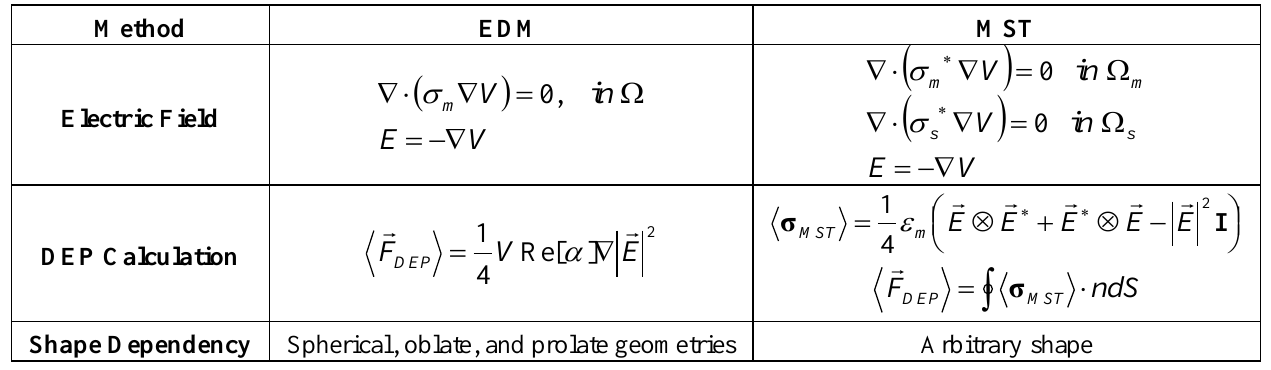
Table 1. Comparison between EDM and MST.